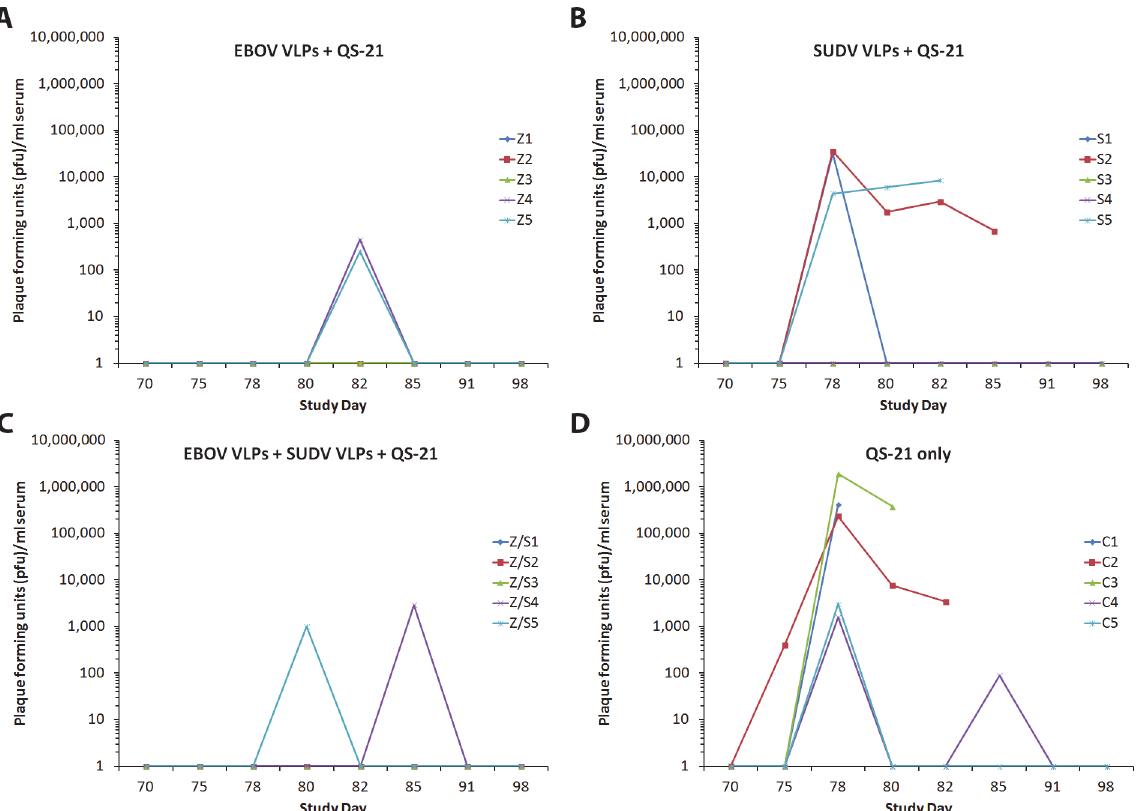
Fig 3. Infectious virus detectable in the sera of NHPs vaccinated with QS-21 adjuvant and EBOV VLPs (A), SUDV VLPs (B), EBOV and SUDV VLPs (C), or adjuvant only (D) and challenged with TAFV on study day 70. Quantitation of virus infectivity was determined using a standard plaque assay and is represented as the values for individual monkeys on each study day after the challenge date (day